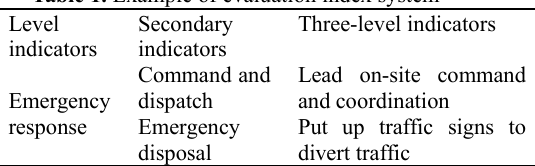
Table 1. Example of evaluation index